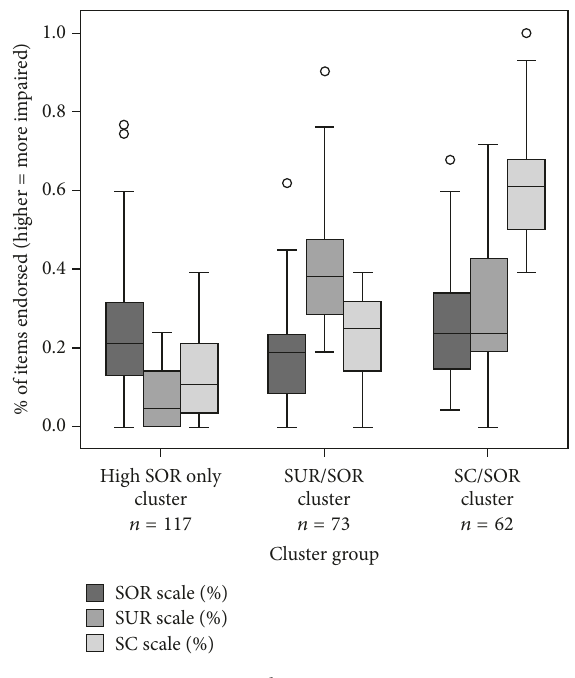
Figure 1: Cluster